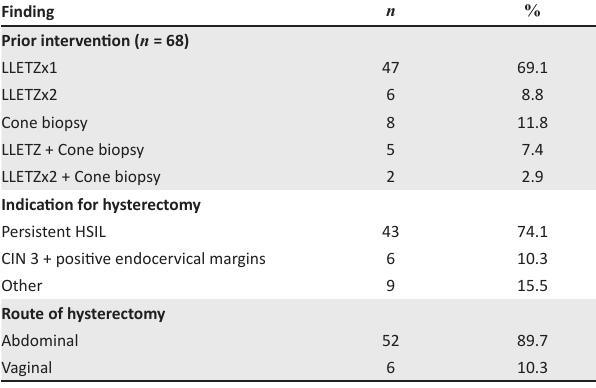
TABLE 2: Treatment details of included women. Finding